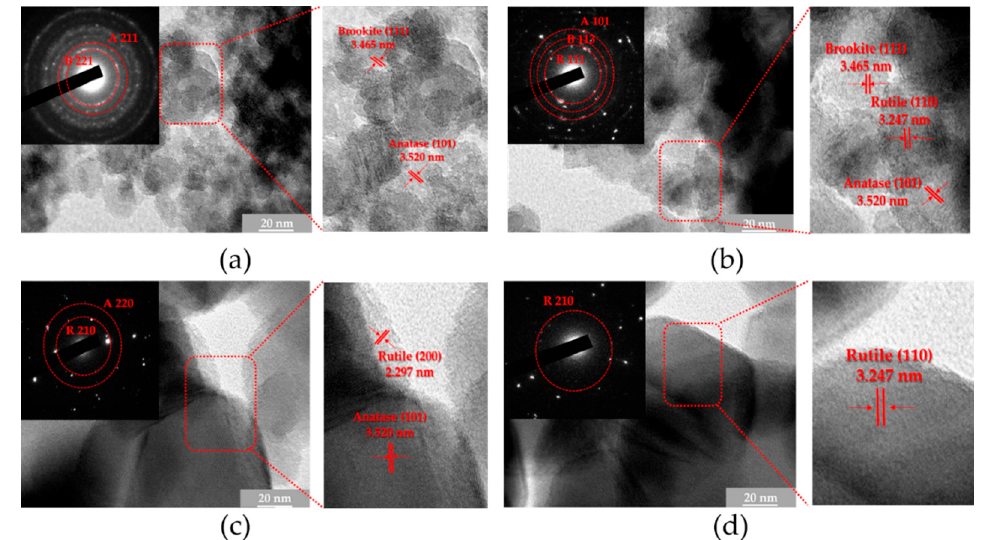
Figure 2. Transmission electron microscope (TEM) images and selected area electron diffraction (SAED) (inset) images of each TiO 2 particles calcined at ( a ) 300 °C, ( b ) 600 °C, ( c ) 700 °C, and ( d ) 800 °C.